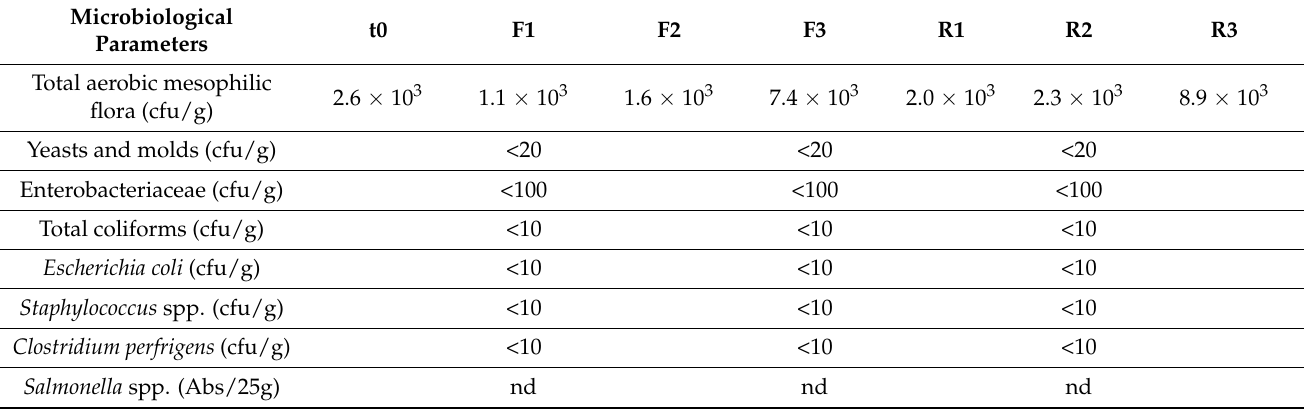
Table 4. Microbiological analysis of total mesophilic bacteria, yeasts and molds, and pathogenic bacteria in A. platensis BEA 1257B biomass samples collected during the time-course of the cultivation experiment from the 8000 L raceway pond inside greenhouse. Sample t0 was collected at the time of RW inoculation, while samples F1, F2 and F3 and samples R1, R2 and R3 were collected during the first phase (F phase, 12 Sep. to 11 Oct.) and the second phase of the experiment (R phase, 11 Oct. to 11 Nov.),